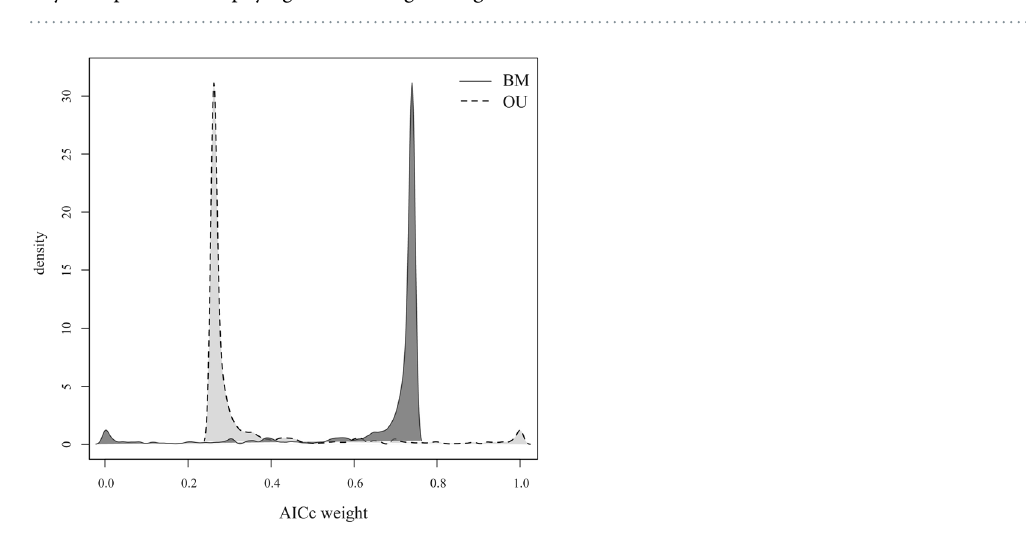
Figure 3. Density distribution of Brownian motion (BM) and Ornstein–Uhlenbeck (OU) models support over 1000 Bayesian post burn-in phylograms for Agrodiaetus species. AICc is Akaike information criterion with a correction for finite sample sizes. AICc weights are the relative likelihood of each model: the weight is smaller if the model is less